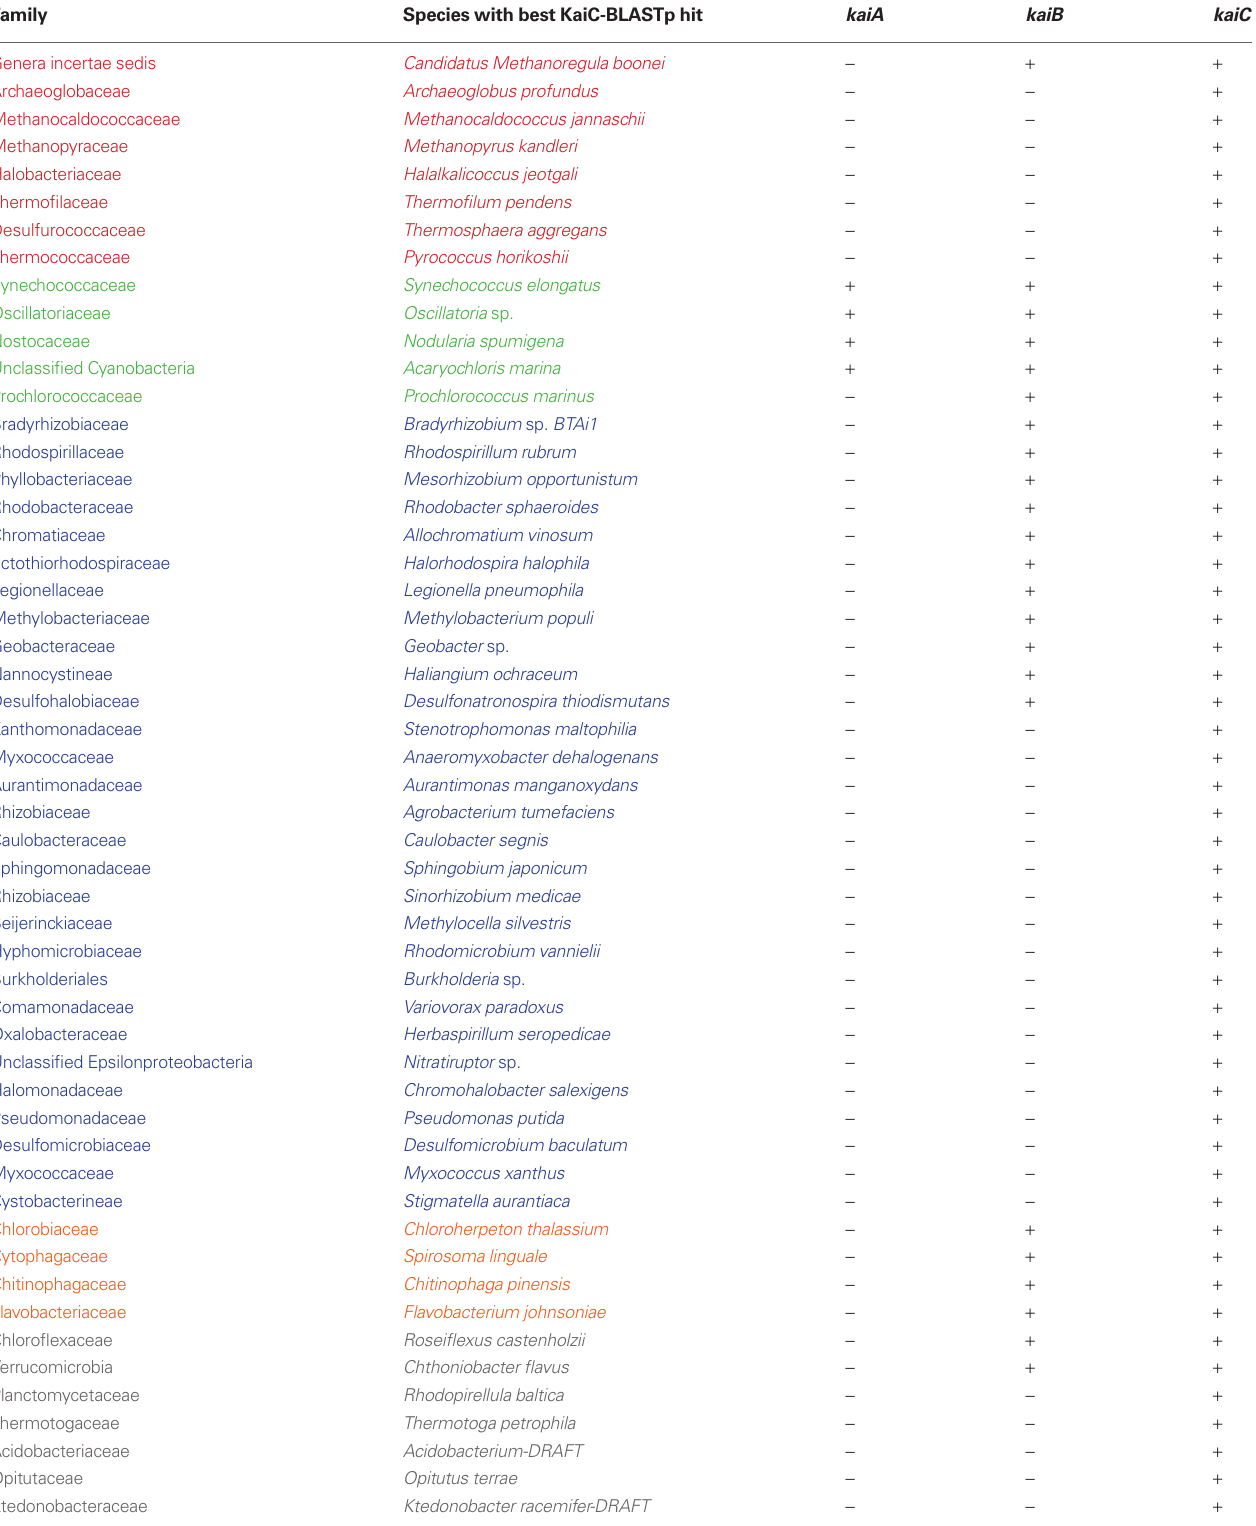
Table 1 | Distribution of KaiA, KaiB, and KaiC homologues in completely sequenced prokaryotic